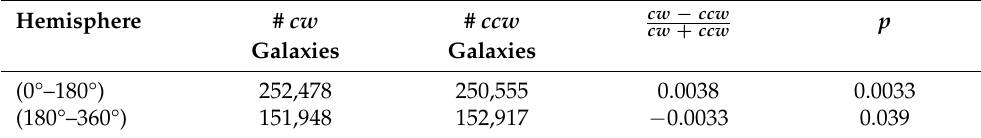
Table 3. Distribution of clockwise and counterclockwise galaxies in opposite hemispheres in DESI Legacy Survey. The p values are the binomial distribution probability to have such difference or stronger by chance when assuming a 0.5 probability for a galaxy to spin clockwise or counterclockwise. Most galaxies in the DESI Legacy Survey used in this study are in the Southern hemisphere. Hemisphere